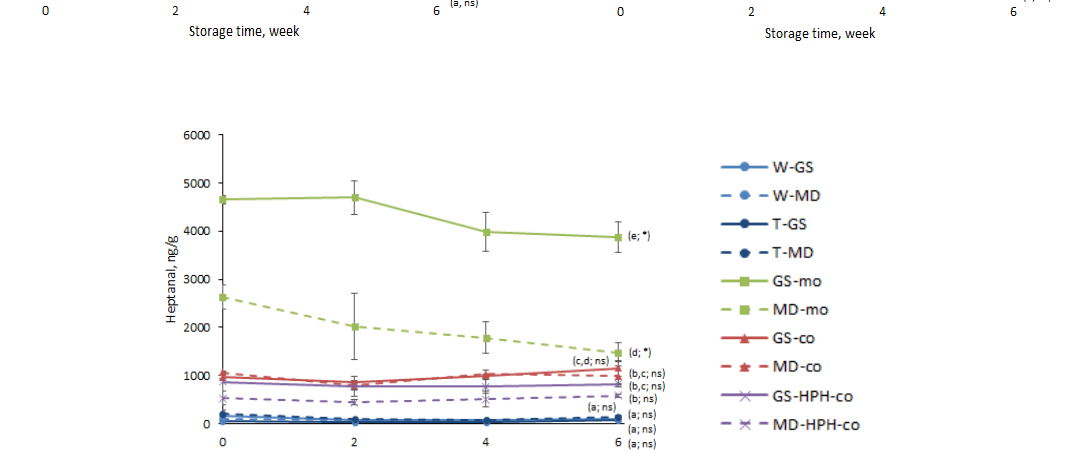
electrospraying (monoaxial and coaxial) during storage: 2-ethylfuran (A) ; 1-penten-3-ol (B) ; ( E,E )-2,4-heptadienal (C) ; ol ( B ); (E,E)-2,4-heptadienal ( C ); hexanal ( D ); heptanal ( E ). Samples followed by a letter (a–e) indicate